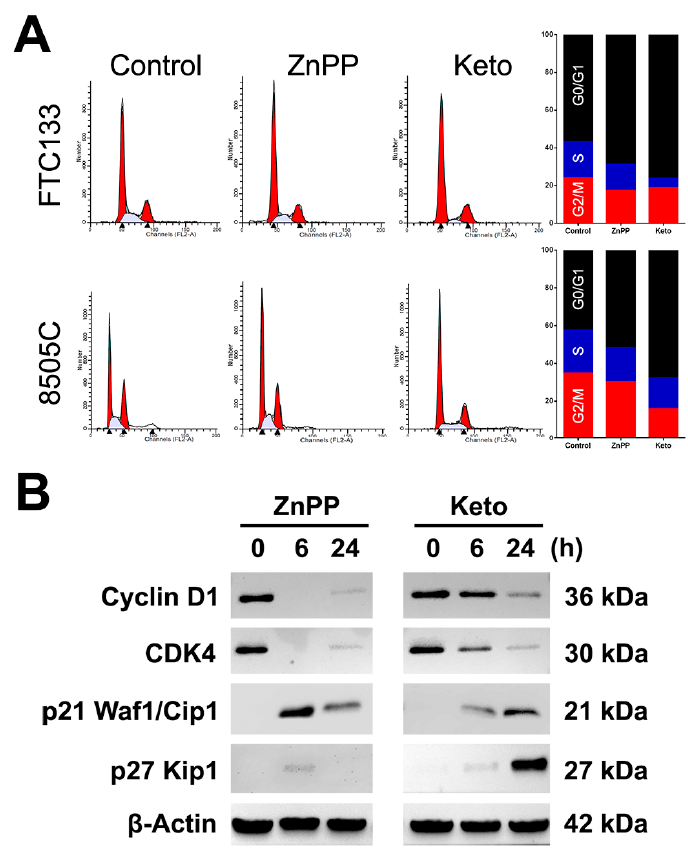
Figure 2. Effects of heme oxygenase-1 inhibitors, zinc protoporphyrin-IX (ZnPP) and ketoconazole (Keto), on cell cycle progression ( A ) and the expression of cell cycle regulators ( B ) in thyroid cancer cells.